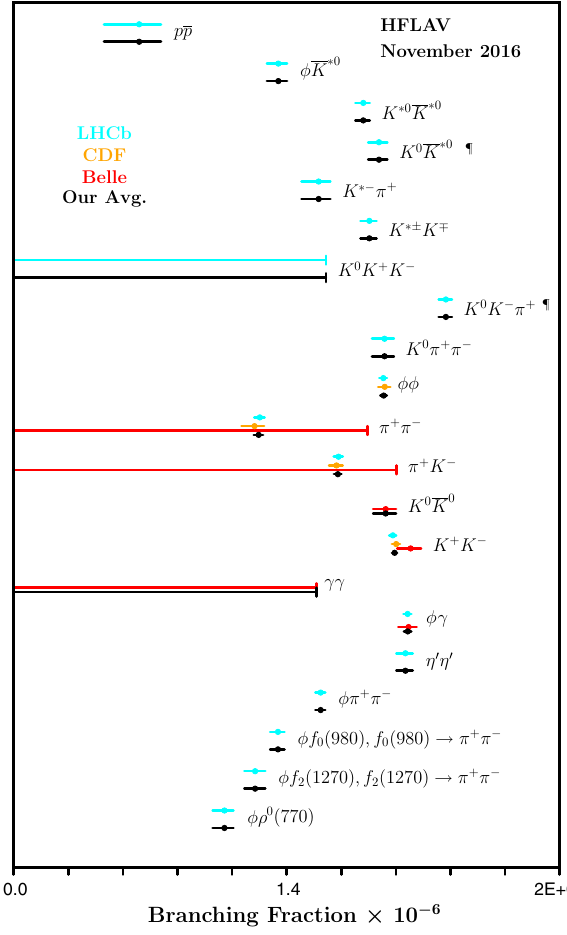
Fig. 180 Branching fractions of charmless non-leptonic B 0 s decays